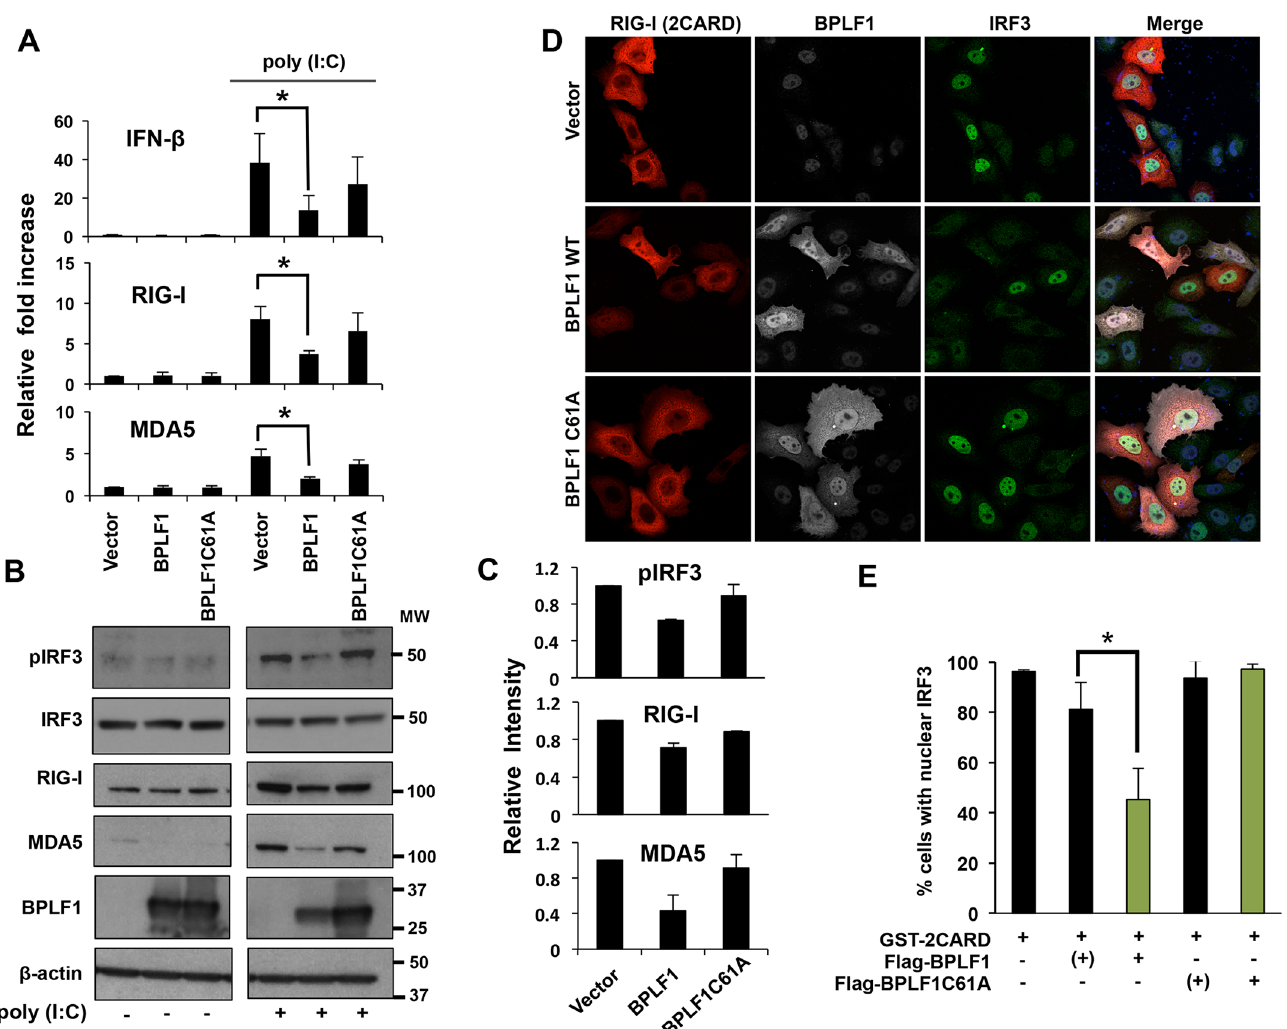
Fig 2. Catalytically active BPLF1 inhibits the IFN response. A . BPLF1 inhibits the transcription of IFN and IFN-regulated genes induced by treatment with poly (I:C) for 20 hrs. The levels of specific mRNAs were quantified by qRT-PCR. The results are shown as fold change relative to mock treated cells. The mean ± SD of 3 experiments each performed in triplicate is shown. B . The phosphorylation of IRF3 and expression of the nucleic acid sensors RIG-I and MDA5 are downregulated in cells expressing active BPLF1. Representative western blots illustrating the protein expression levels of the samples shown in Fig. 2A probed with the indicated specific antibodies. C . The intensities of the specific bands were quantified by densitometry and fold change was calculated relative to the empty vector transfected cells. The mean ± SD of two experiments is shown. D . Active BPLF1 inhibits the nuclear translocation of IRF3 in cells activated by transfection with GST-2CARD. Confocal images were obtained at 63x lens objective magnification. IRF3 is in green, RIG-I-2CARD is in red, BPLF1 in far red and cell nuclei were stained with Hoechst (blue). E . Statistical analysis of the percentage of cells exhibiting nuclear IRF3. The bars depict the average percentage of cells with nuclear IRF3 in cells expressing GST-2CARD with or without BPLF1 co-expression. BPLF1 transfected cells that did not express detectable amounts of the protein are indicated as (+). The mean ± SD of three independent experiments is shown.